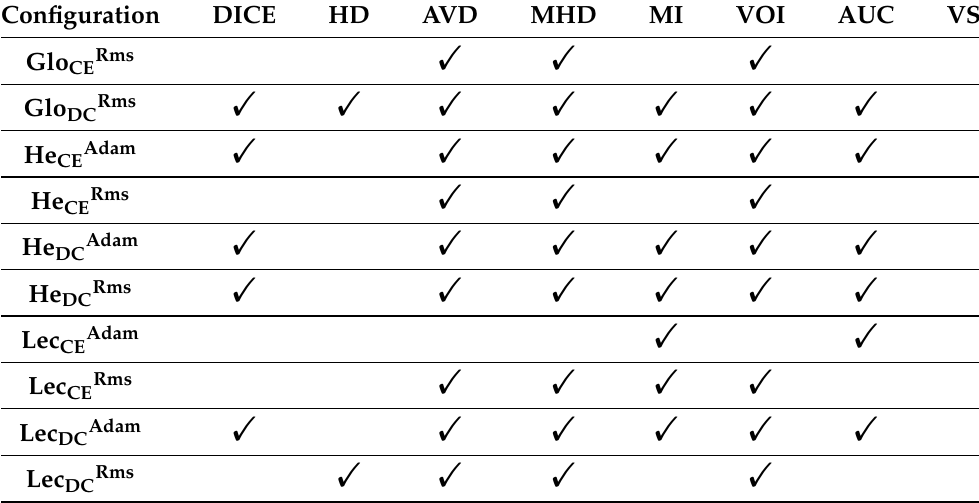
Table 5. Statistical Significant differences ( p ≤ 0.05) denoted by checkmark for each configuration in comparison to Glo Adam for Liver CE